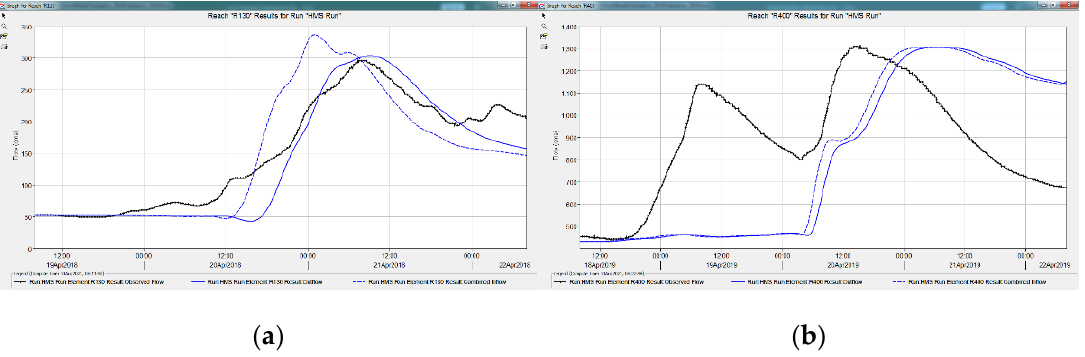
Figure 4. Actual (black) and simulated (blue) hydrographs of two floods ( a ) in Guilin during 19-22 Apr 2018 and ( b ) in Yangshuo station during 18-22 Apr 2019 before inclusion of ARCK and dams in the model.